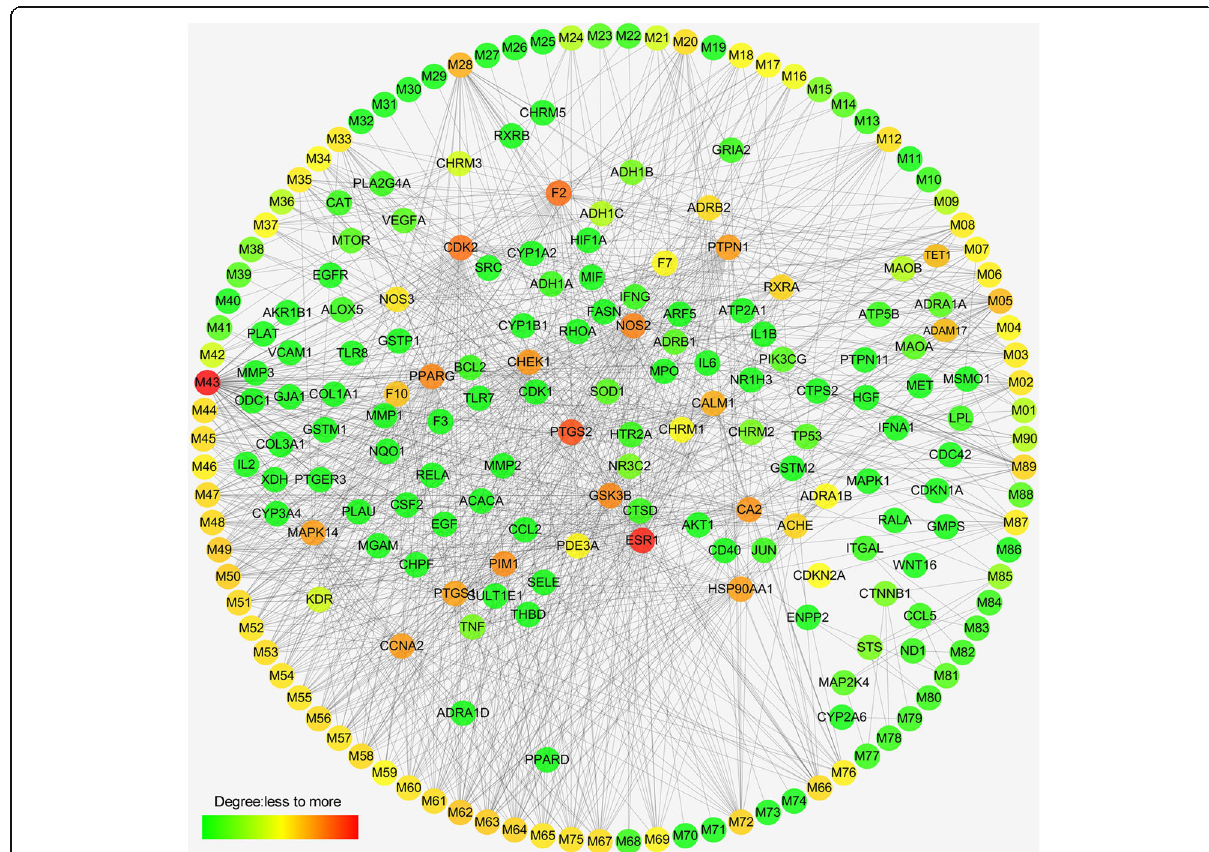
Fig. 5 Compound – target network. Circular nodes represent the effective chemical compounds, and rectangle nodes represent the therapeutic target